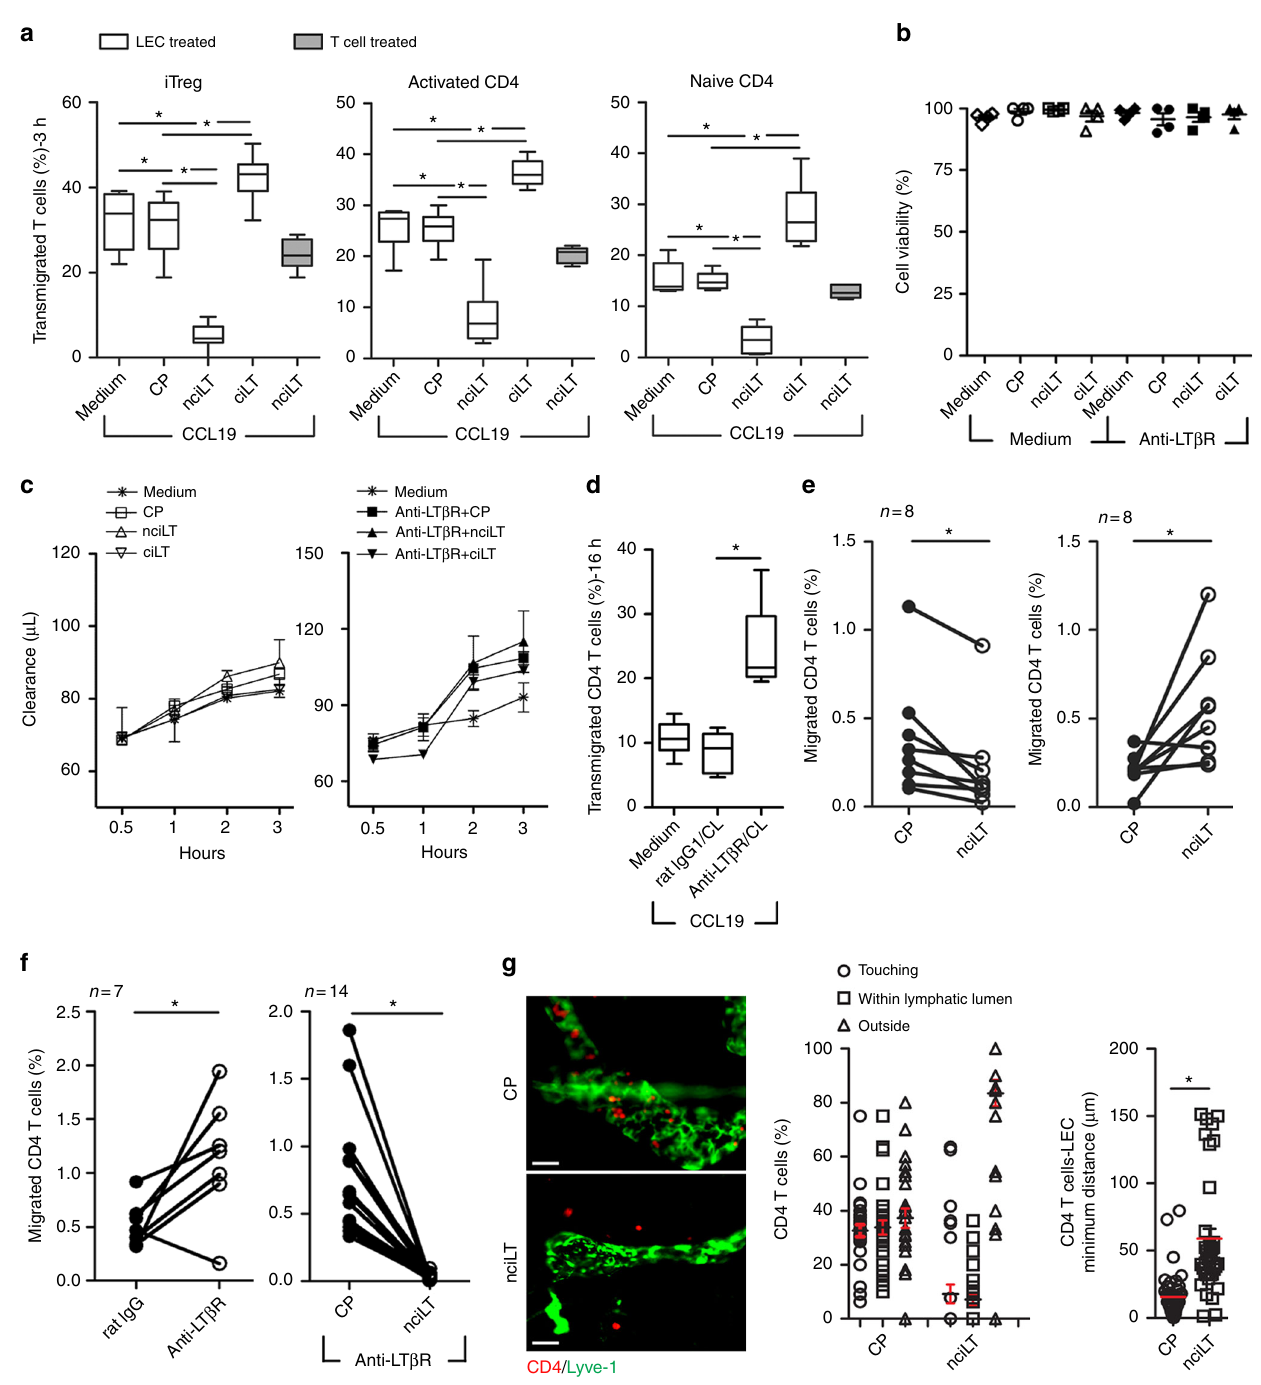
Fig. 5 LT β R peptides that block non-classical NF κ B signaling pathway inhibit CD4 T cell migration across LEC. a LEC cell layers pretreated with the indicated peptides (20 μ M) for 30 min at 37 °C and then Foxp3 + CD4 + CD25 + iTregs, Foxp3 − CD25 − CD4 + aCD4, or naïve CD4 cells loaded into upper chamber and migrated toward CCL19 (50 ng/mL) for 3 h. b LEC incubated with 20 μ M nciLT or ciLT peptides for 3 h without or with stimulation with 2 μ g/ mL anti-LT β R mAb. Cell viability determined by MTT incorporation assay. c Time-course monitoring of 0.75% albumin/Evans Blue diffusion across LEC cell layer in Boyden chamber treated as in b . d LEC cell layers pretreated with anti-LT β R mAb or isotype rat IgG for 30 min at 4 °C, washed and CL with mouse anti-rat IgG1 for 30 min at 37 °C, followed by 16 h incubation, then naïve CD4 cells loaded into the upper chambers and migrated toward CCL19 (50 ng/mL) for 3 h. e , f Footpad-popliteal LN migration assay. 1 × 10 6 CFSE-labelled naïve CD4 T cells mixed with 5 nmol CP (left side), 5 nmol nciLT (right side), or 5 nmol ciLT (right side) without ( e ) or with 1 μ g anti-LT β R mAb ( f ), injected into hind footpads. After 16 h popliteal LNs collected and analyzed with fl ow cytometry. g Ear whole-mount staining and migration. CFSE-naïve CD4 T cells injected into ear pinnae pretreated with peptides (5 nmol/ear), and collected after 16 h post injection. Images of T cells and Lyve-1 + lymphatic vessels (left). Magni fi cation ×20; scale bar 50 μ m. Position (center) and distance (right) of T cells with respect to lymphatic vessels. a – g Mean± SEM of at least three independent experiments. * p < 0.05 by one-way ANOVA ( a – d ) or by Student ’ s t- test ( e – g